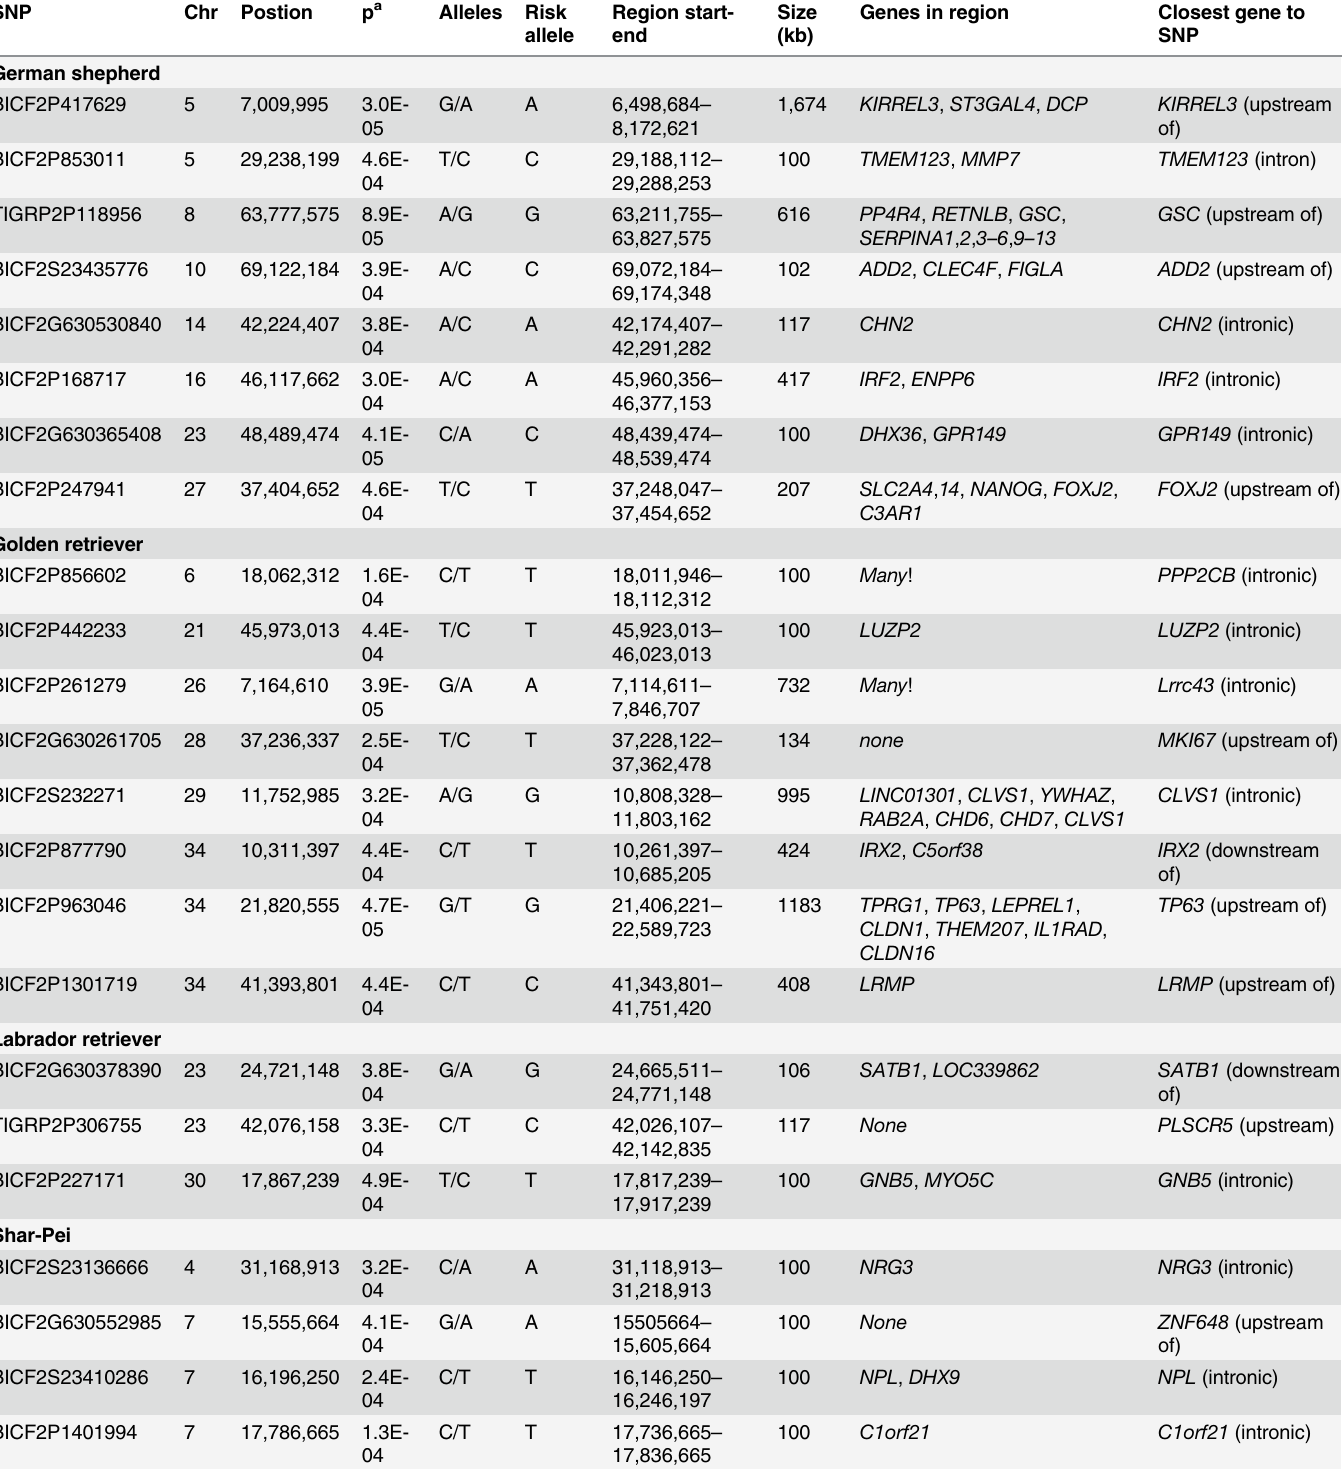
Table 1. Genomic loci nominally associated with IgA